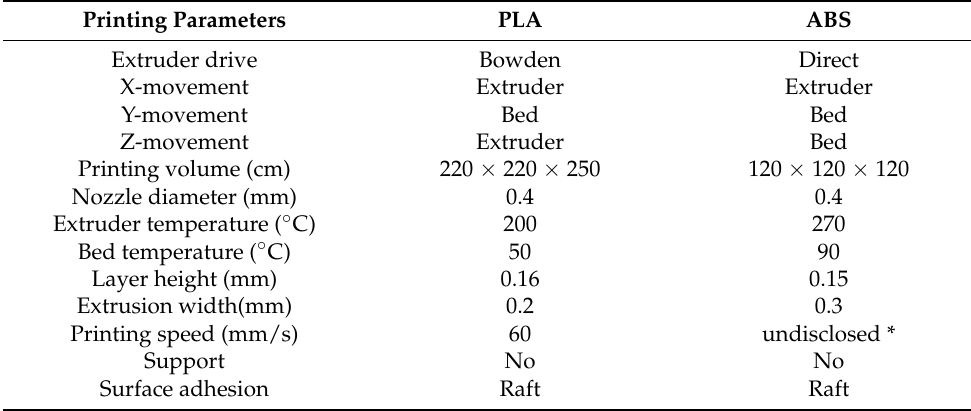
Table 3. Configuration of the printers and printing parameters.